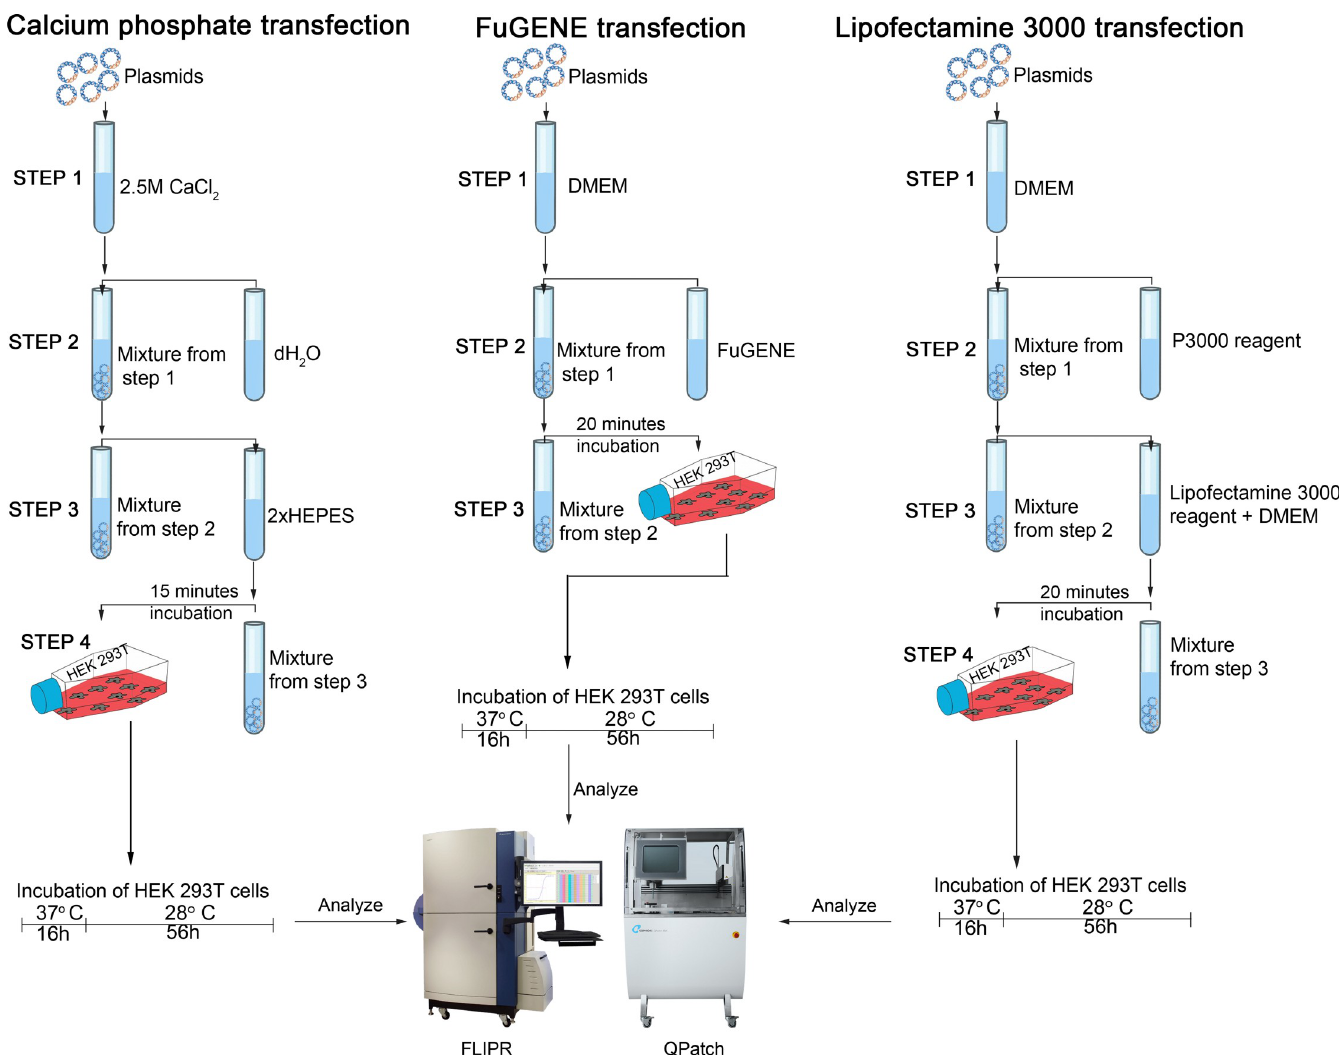
Fig 2. Chemical transfection